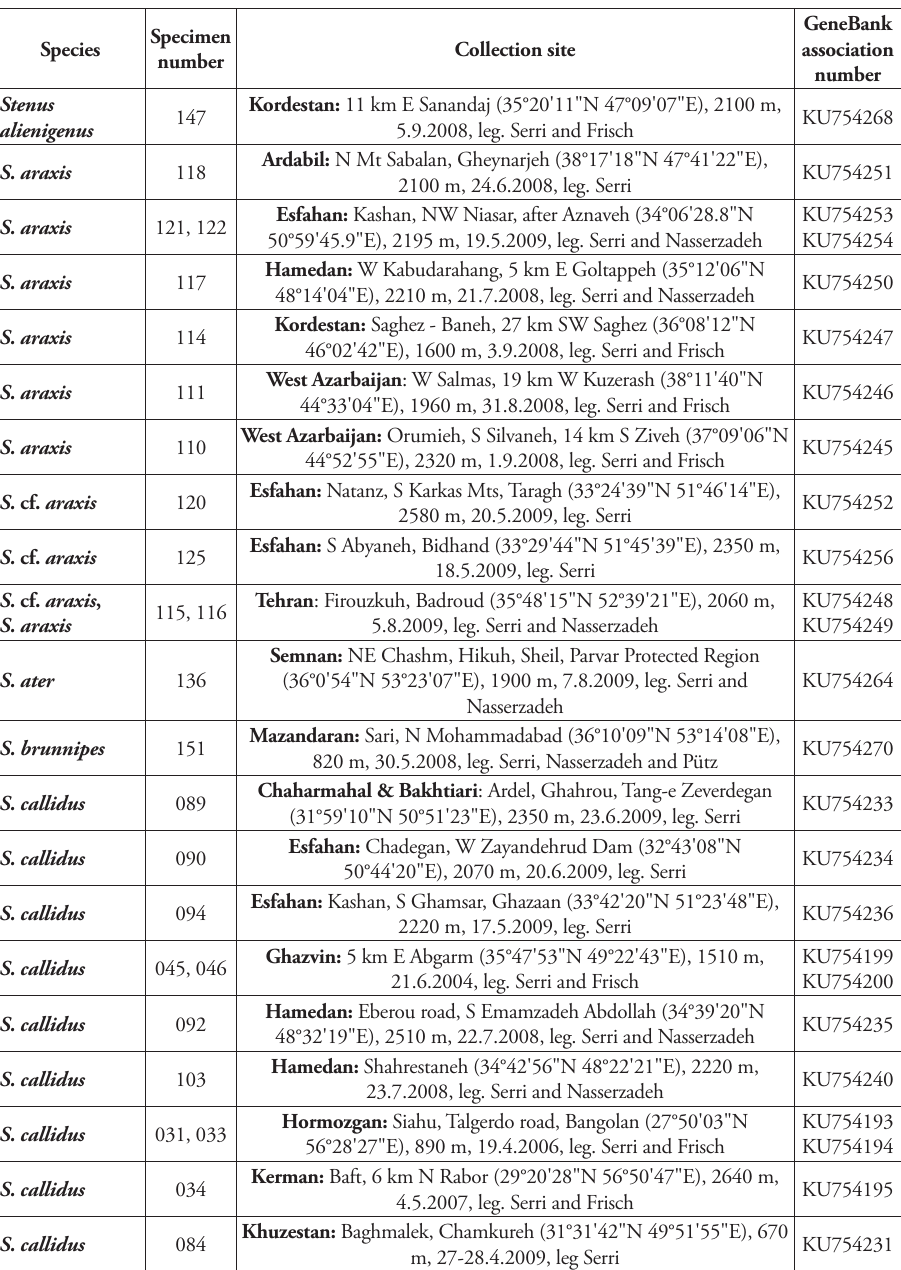
Table 1. The specimens used in this study with their location data and the GenBank association number of submitted sequences of COI. The specimen number codes the geographical origin of the specimens in the phylogenetic tree (Figures 7,